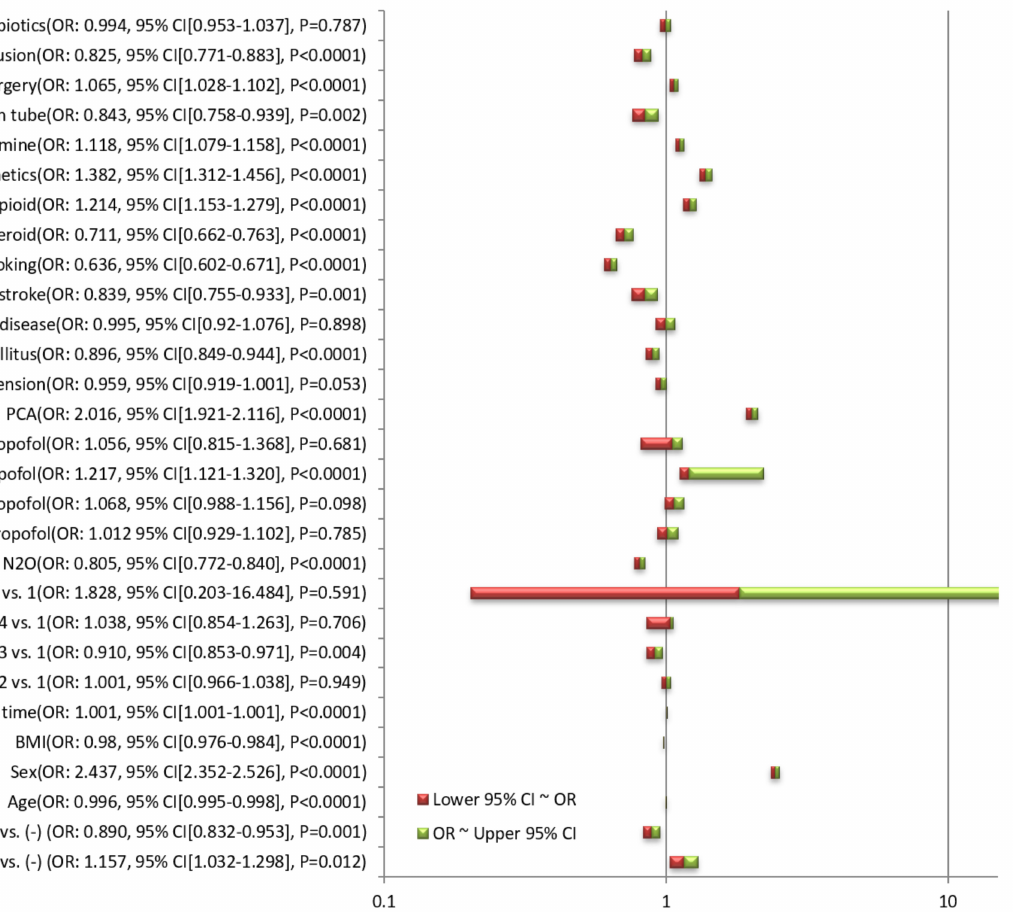
Figure 2. Adjusted odds ratios for the occurrence of PONV of each variable obtained through multivariate logistic regression including all variables. GERD, gastroesophageal reflux disease; PPI, proton pump inhibitor; BMI, body mass index; ASA, American Society of Anesthesiologist Physical Status; Iso., isoflurane; Sevo., sevoflurane; Des., desflurane; Enf., enflurane; PCA, patient-controlled analgesia; LS, laparoscopic; OR, odds ratio; CI, confidence interval; PONV, postoperative nausea and vomiting. Table 2. Adjusted odds ratios for the occurrence of PONV by GERD and PPI status. Odds Ratio (95% CI) p -Value GERD